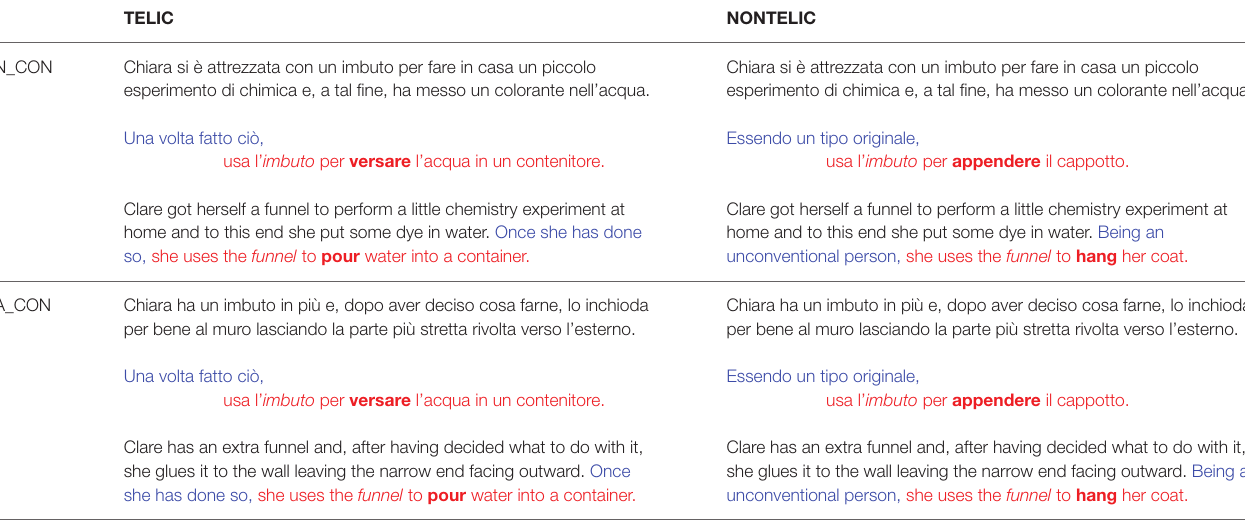
TABLE 1 | Example of experimental stimuli with English translation.